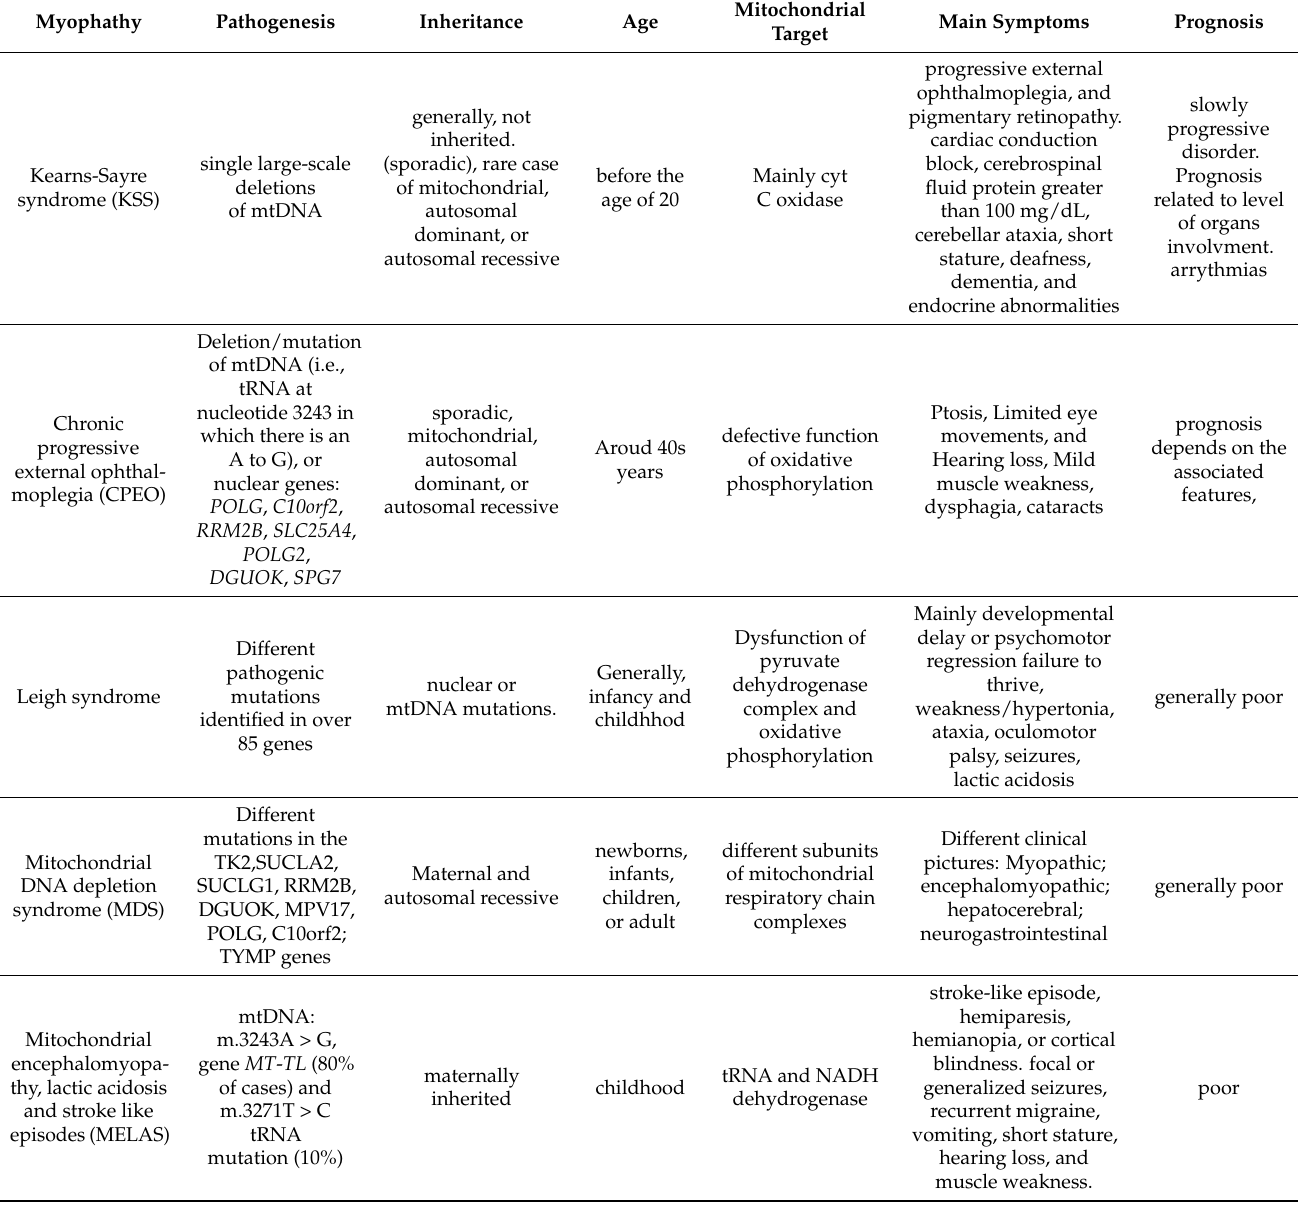
Table 1. Typical mitochondrial myopathies that are generally multisystem